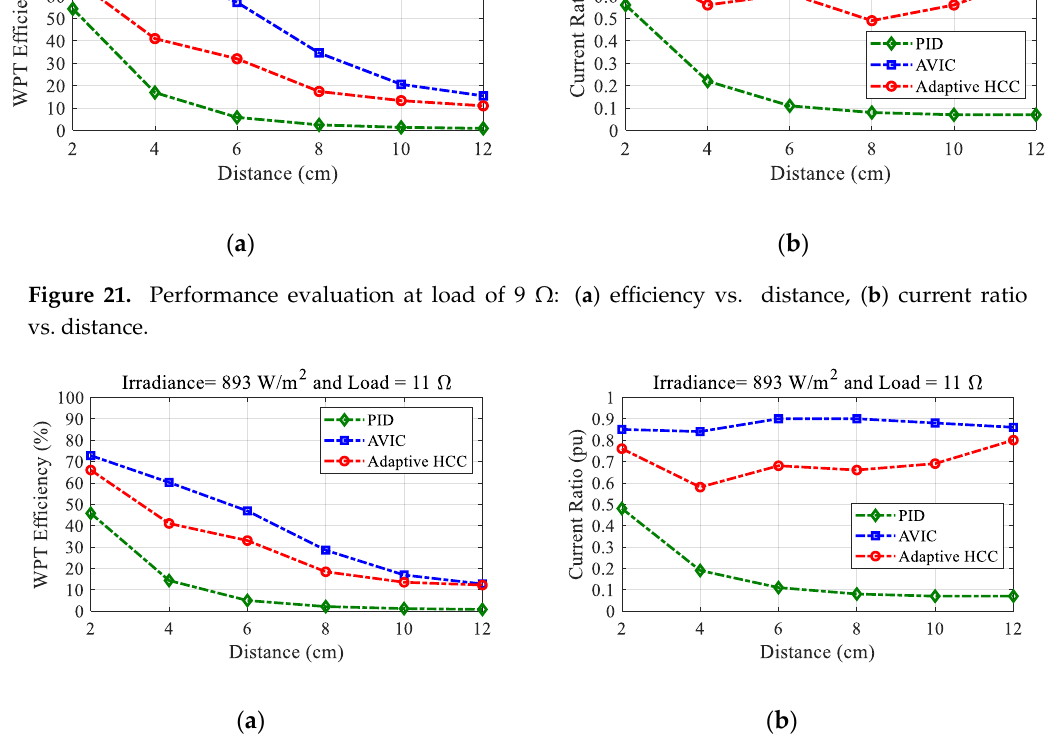
Figure 22. Performance evaluation at load of 66 Ω: ( a ) efficiency vs. distance, ( b ) current ratio vs. distance.